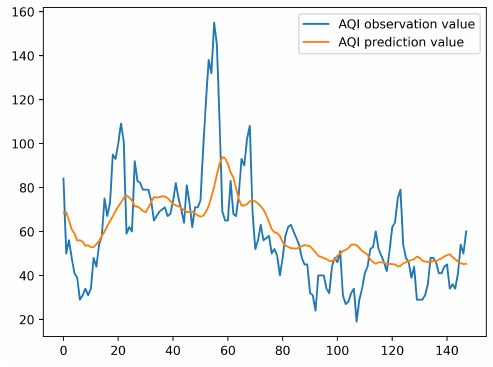
Figure 5. DNN air quality index prediction results.